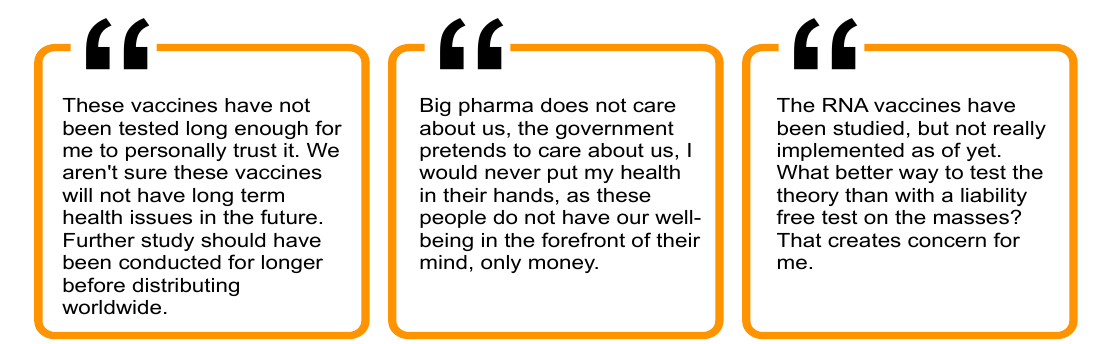
Figure 4. Participant perspectives regarding mistrust in medical community.